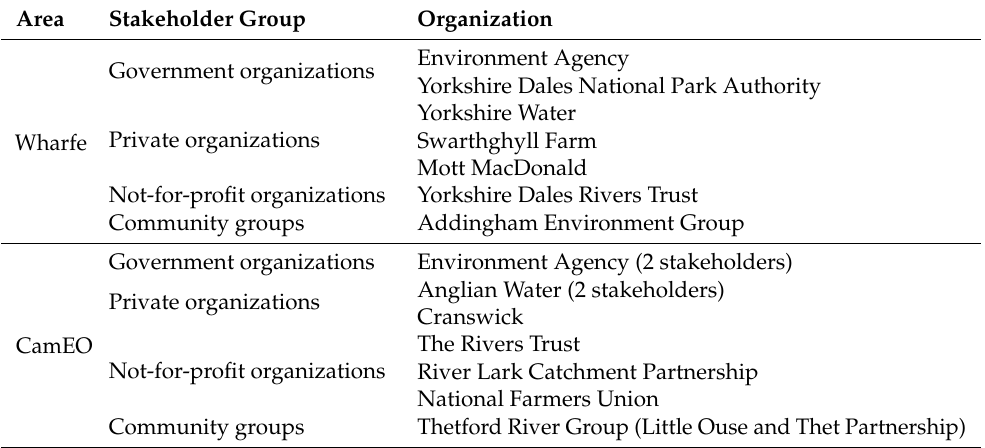
Table 1. Participants in the UK